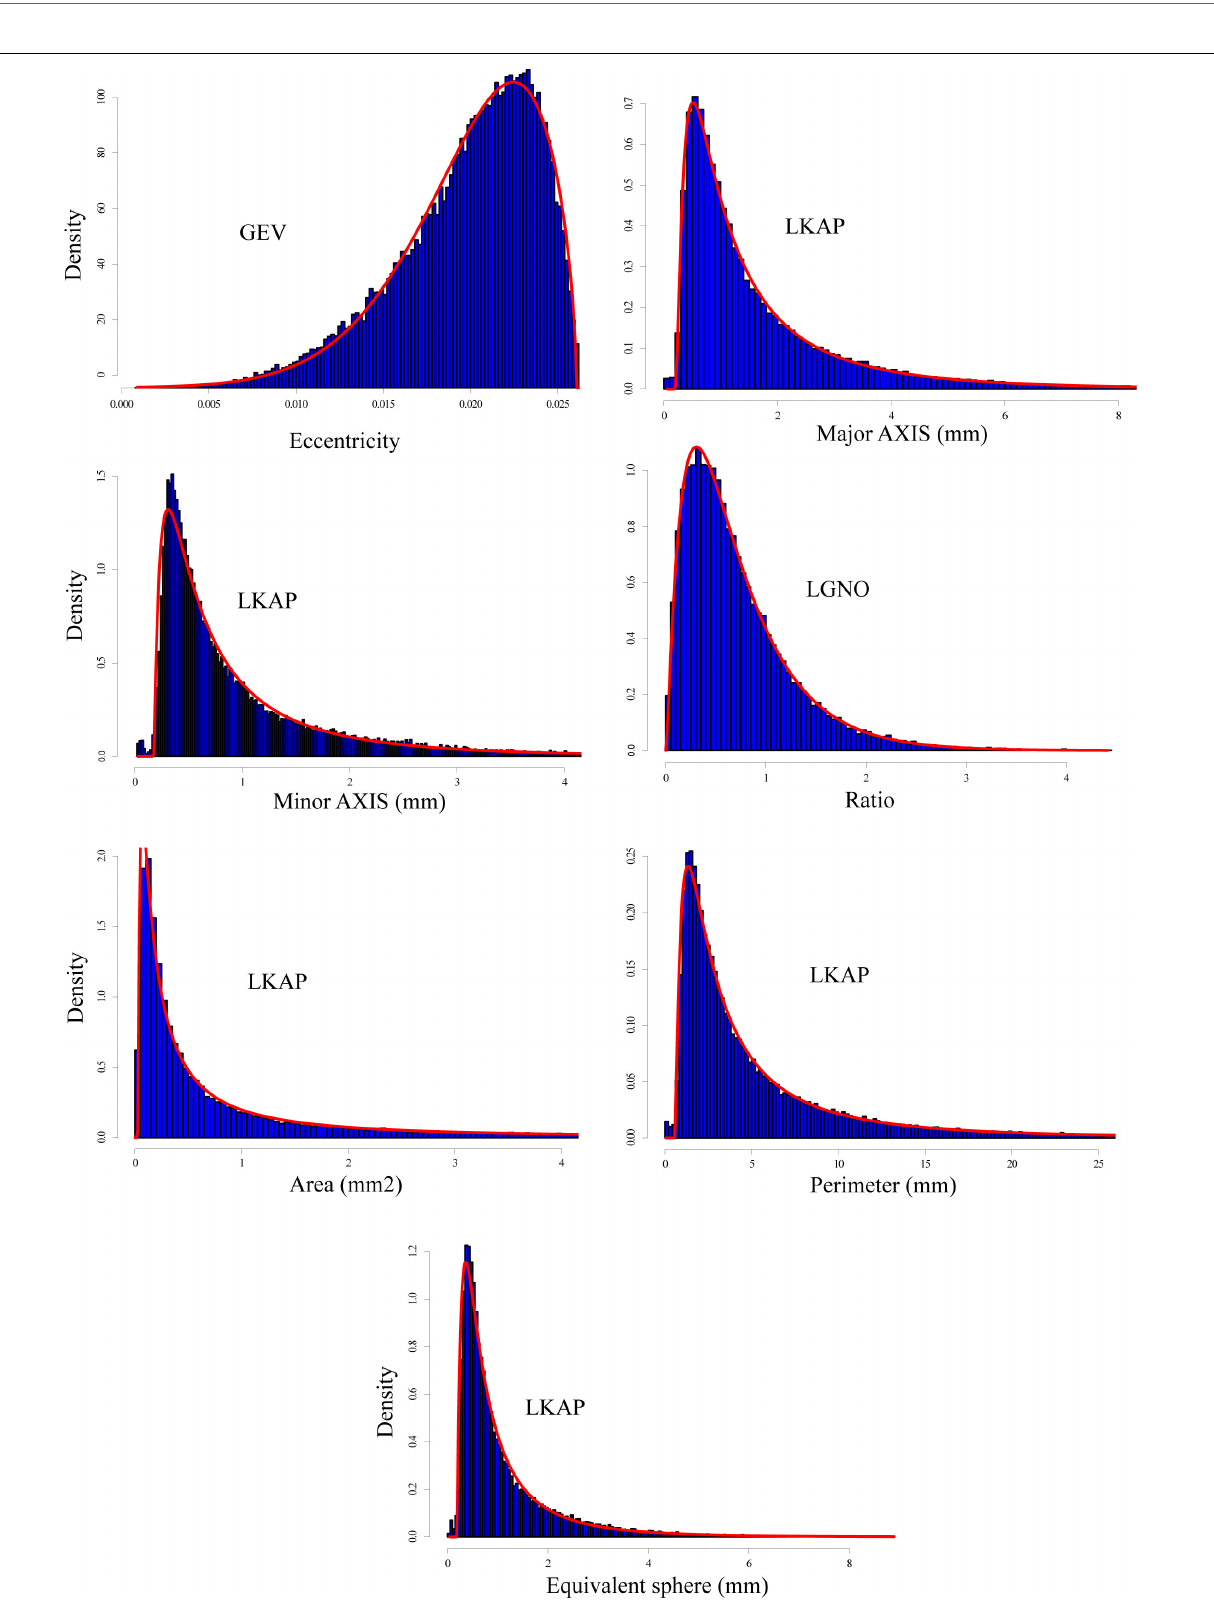
Frontiers in Earth Science |